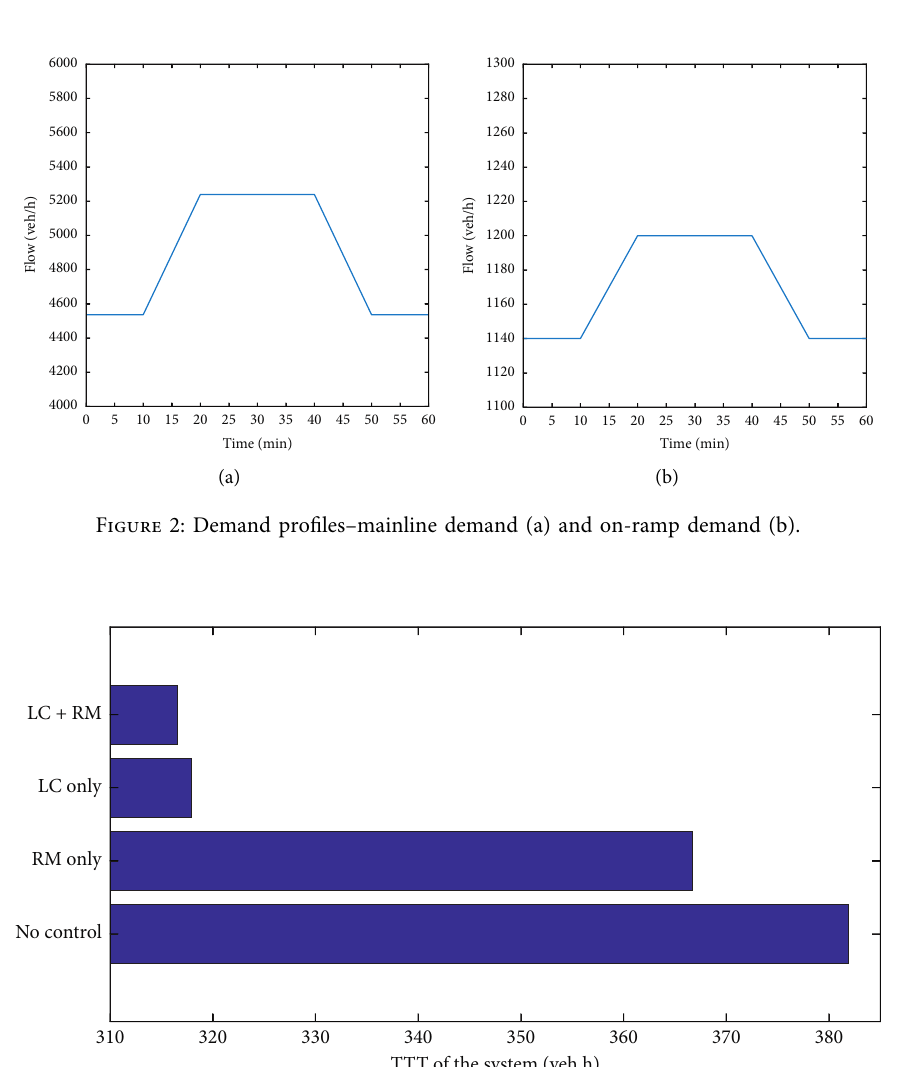
Figure 1: Benchmark network.